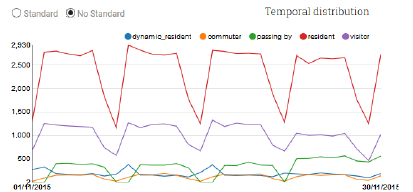
Figure 13. Temporal Distribution in Zone OMI E1.